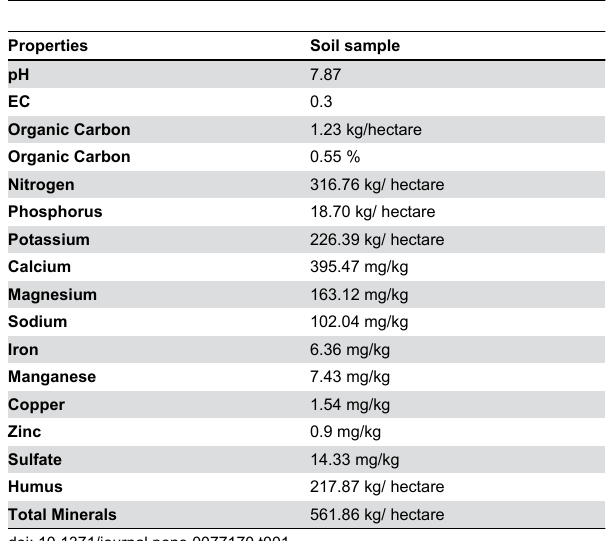
Table 1. Chemical properties of the soil used in the